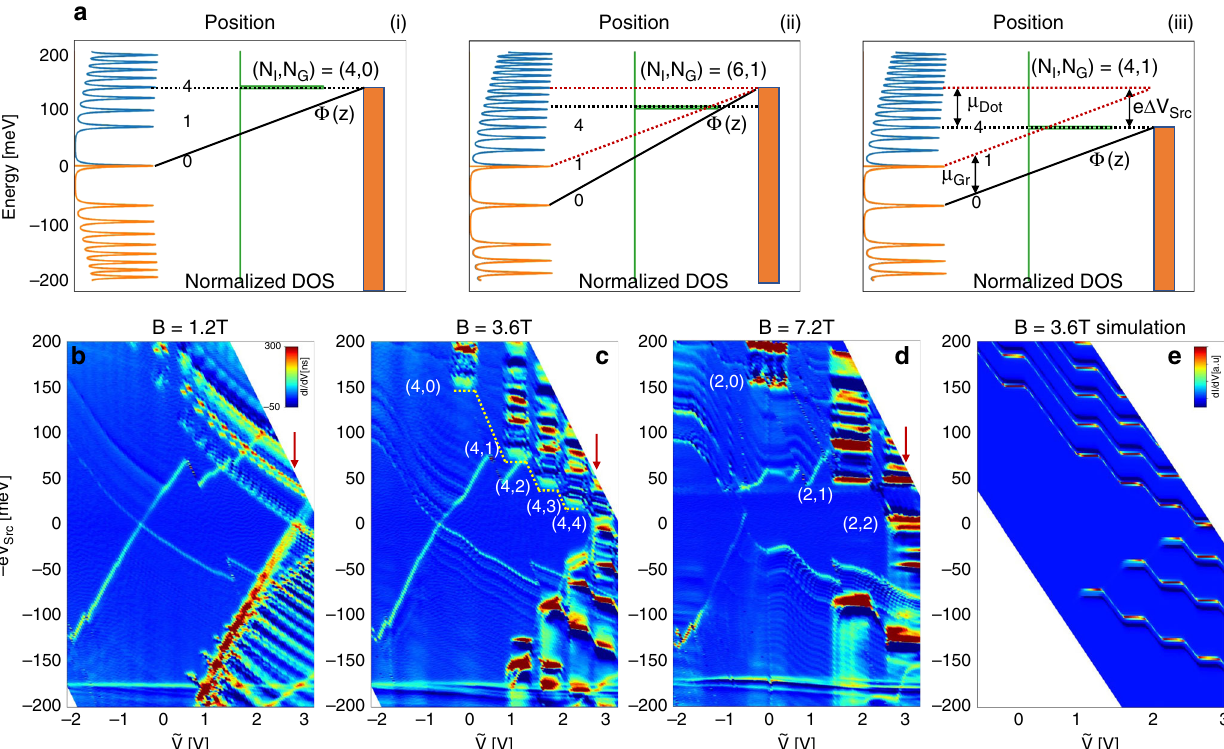
Fig. 2 Tunneling through a quantum dot at fi nite magnetic fi eld. a Energy diagrams describing dot energy (black dashed line) with respect to graphene spectrum (orange — occupied levels, blue — unoccupied levels). Panels (i) – (iii) correspond to the transition from ( N I , N G ) = (4, 0) to (4, 1). The transition from (i) to (iii) is decomposed into two steps: Constant bias (i, ii) where ( N I , N G ) changes from (4, 0) to (6, 1), and constant density (ii, iii) where the injection level is recovered (( N I , N G ) = (4, 1)). The red dashed line re fl ects ϕ ( z ) and μ D ot at (i). Variation in e V Src between (i) and (iii) equals the change in μ – d d I /d V maps at B = 1.2 T, B = 3.6 T and B = 7.2 T. The dashed line in c marks a simulated trajectory where injection level remains constant while G r . b varying the ground state. The horizontal axis shows ~ V , a linear combination of V Src and V Gate such that the density is constant along vertical lines. Red arrows mark ~ V ¼ 2 : 8 V which corresponds to n G r = 3.1 × 10 12 cm − 2 , where Fig. 3a is measured. e Simulated d I /d V map at B = 3.6 T shows the same step structure as the data. The steps corresponding to illustrations (i) – (iii) in a are